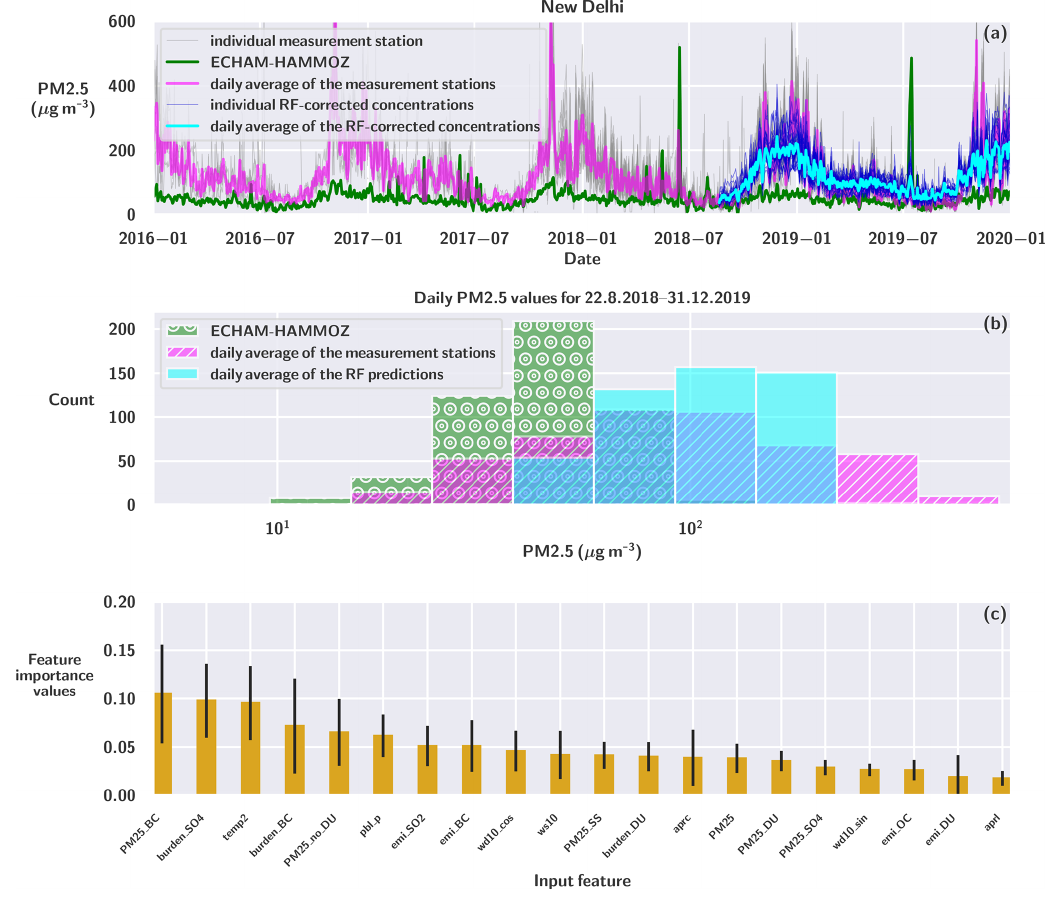
Figure 1. The results for random forest regression fitting for the RF_TRAIN simulation. (a) The solid green line represents ECHAM- HAMMOZ-derived PM 2 . 5 which includes mineral dust. The thinner gray lines represent individual measurement station data, which were used for training. The pink line represents the daily average of all the stations. The thin dark-blue lines show the individual RF-corrected PM 2 . 5 values for each station, and the thicker turquoise line is the average of all the RF-corrected PM 2 . 5 . (b) The distribution of daily PM 2 . 5 values for the testing phase (22 August 2018–31 December 2019). The green bars filled with white circles show the distribution of ECHAM-HAMMOZ daily PM 2 . 5 concentrations. The pink bars with slashes indicate the daily average PM 2 . 5 values for the average of the measurement stations. The turquoise bars show the daily average RF-corrected PM 2 . 5 values. (c) The average normalized feature importance values for the input features are represented with yellow bars. The black whiskers show the standard deviation of individual RF model importance values.